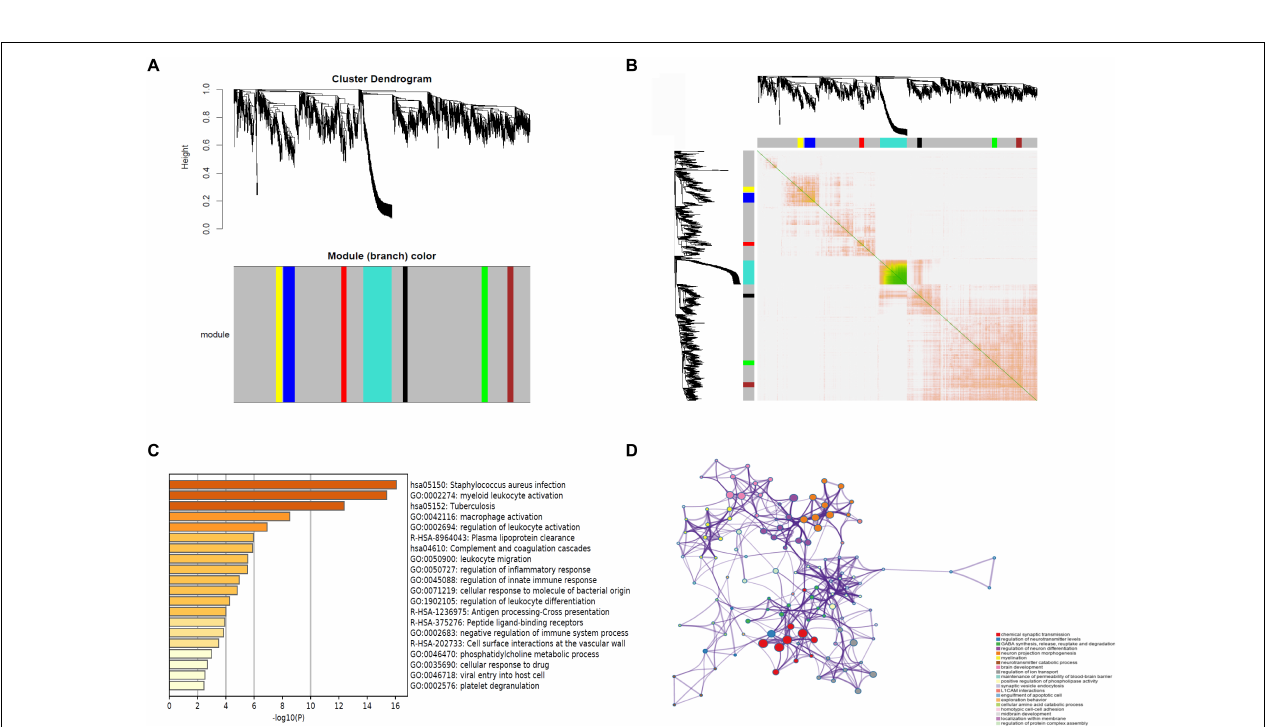
FIGURE 3 | WGCNA of DEGs. (A) Cluster dendrogram and module assignment for modules from WGCNA. X axis represents genes, and Y axis represents height of the gene tree. The colored horizontal bar below the dendrogram represents the module that contains a group of highly connected genes. (B) Clustering of the DEGs by topological overlap shows that seven gene modules characterized by distinct expression patterns comprised highly coregulated genes. The color intensity in the heatmap is proportional to the interaction strength between two genes with green color for the strongest interaction and white color for no interaction. The seven modules are represented by the color bars along the X and Y axes. The blue and turquoise modules represent the top two modules. (C) The genes in the blue module are enriched in myeloid leukocyte activation, macrophage activation, and regulation of leukocyte activation. (D) The genes in the turquoise module are related to chemical synaptic transmission, regulation of neurotransmitter levels, and regulation of neuron differentiation. WGCNA, weighted gene coexpression network analysis.